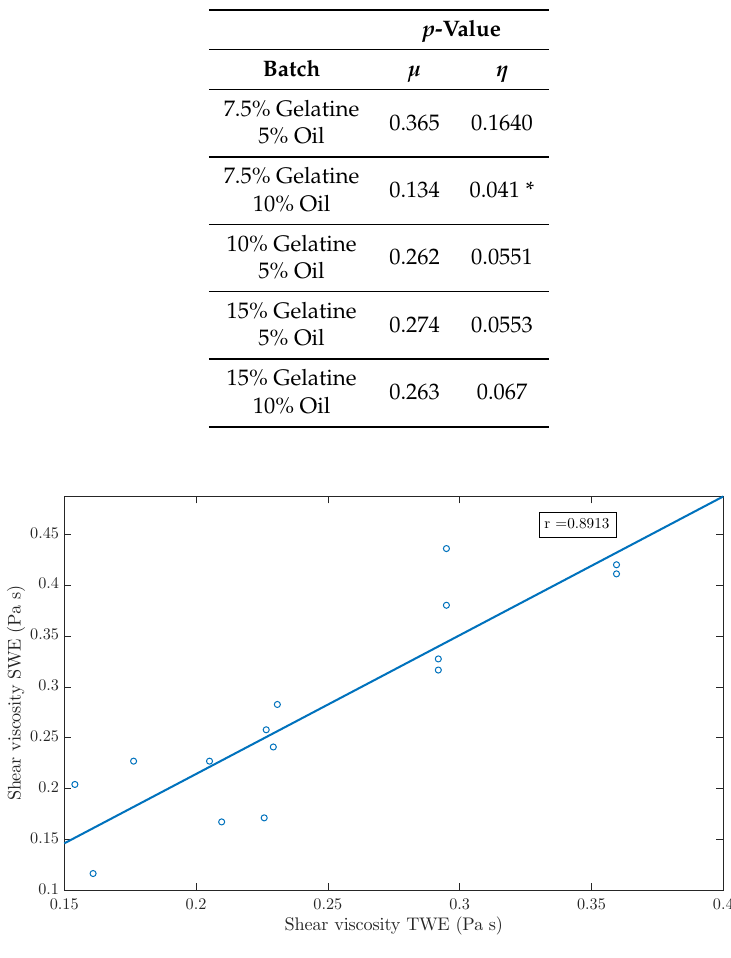
Figure 13. Pearson’s correlation between shear viscosity measured with TWE and shear viscosity obtained with SWE. Pearson correlation coefficient r =